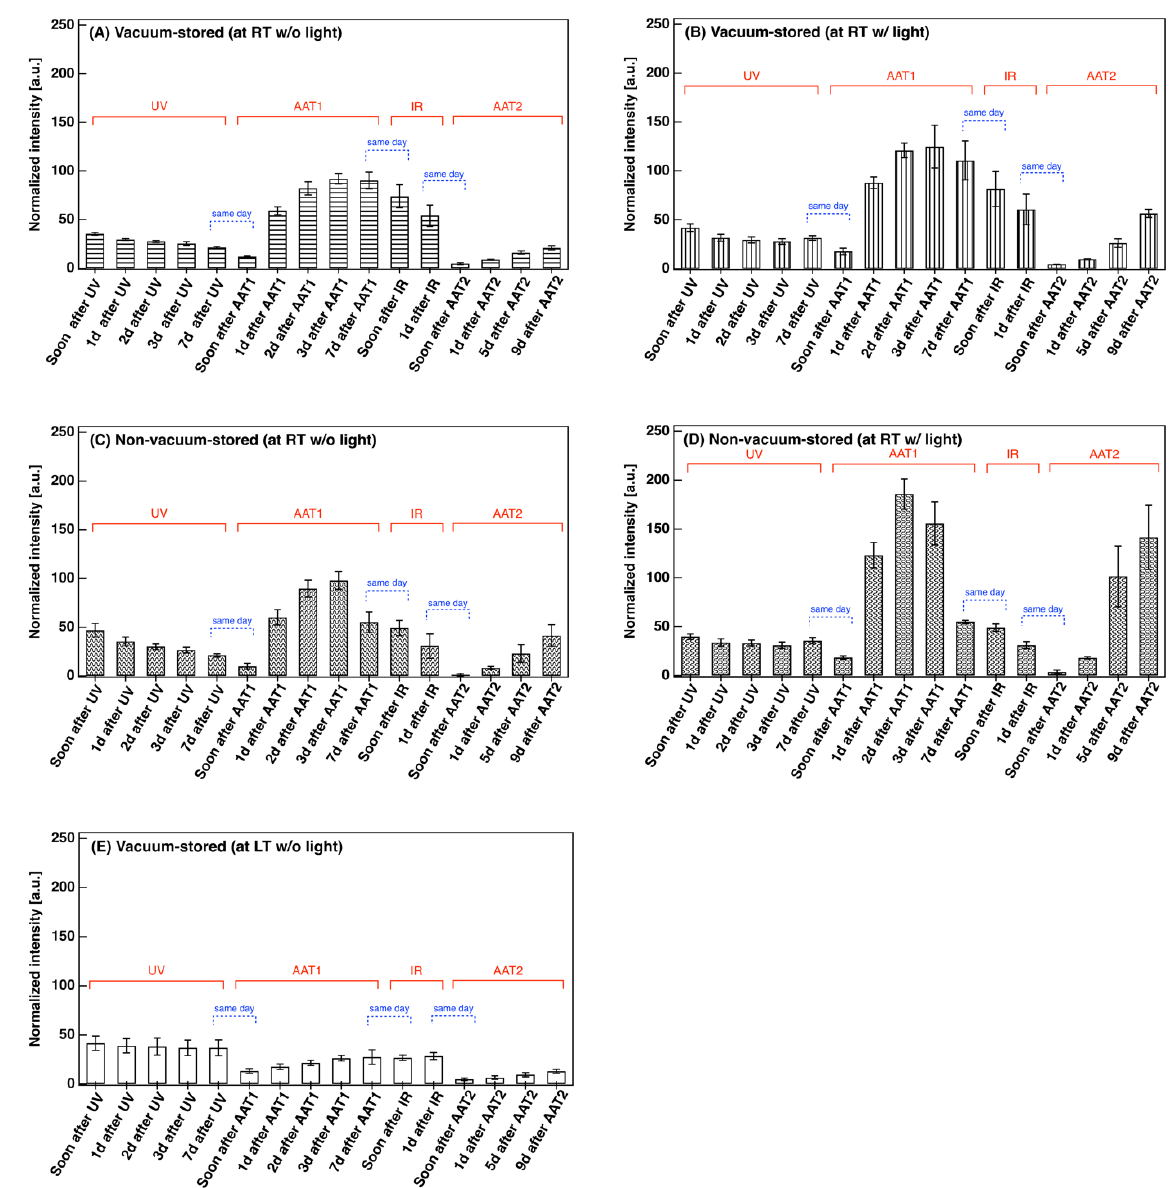
Figure 7. ESR peak-to-peak intensity changes obtained from fingernail samples stored under different storage conditions, as described in steps 1–4 of Experiment 2. Each point was calculated as the average of three AAT samples and subtracted from the WT control sample. The error bars were obtained as the standard deviation of three samples. The notations RT, LT, w/light, and w/o light are the same as in Figure 4.